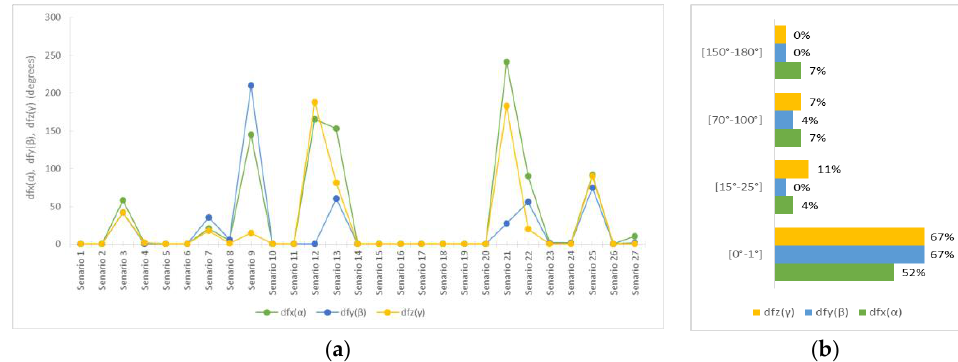
Figure 6. ( a ) Deviations in degrees for rotation angles per axis in the quaternion method. ( b ) Histogram of deviations for rotation angles per axis in the quaternion method.